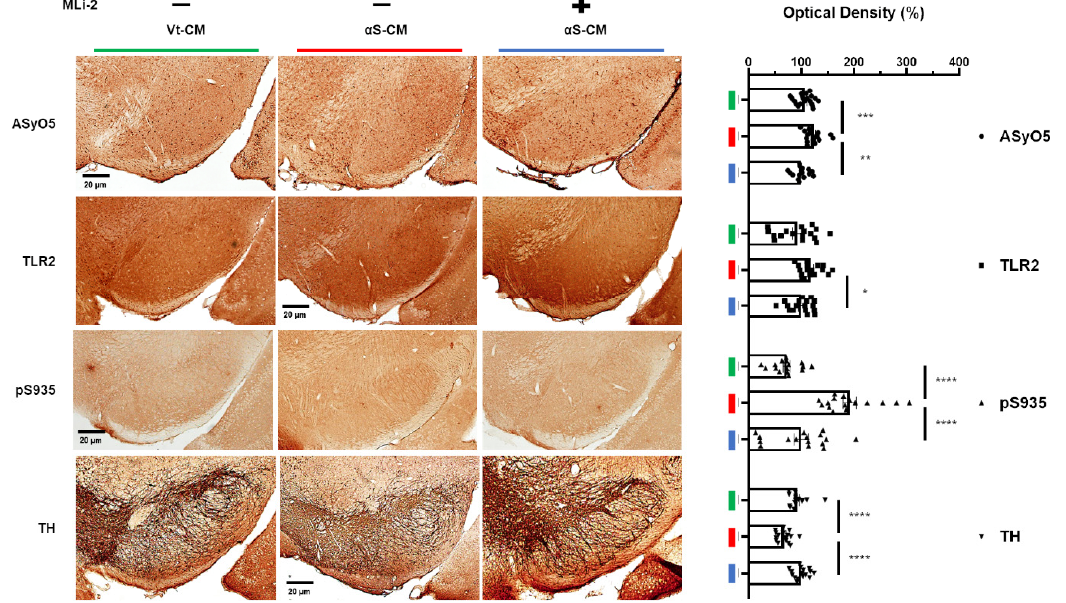
Figure 7. Administration of an LRRK2 inhibitor upregulated microglial activation by TLR2-specific α Syn oligomer. The optical density of α Syn oligomer recognized on the basis of AsyO5 antibody binding (circle), TLR2 (square), phosphorylation at S935 of LRRK2 (triangle), and the TH (reversed triangle) in the SN were estimated in the mice on day 28. n = 4, approximately 16–20 sections for IHC. * p < 0.05, ** p < 0.01, *** p < 0.001, and **** p < 0.0001. All data are represented as the mean ± SEM.